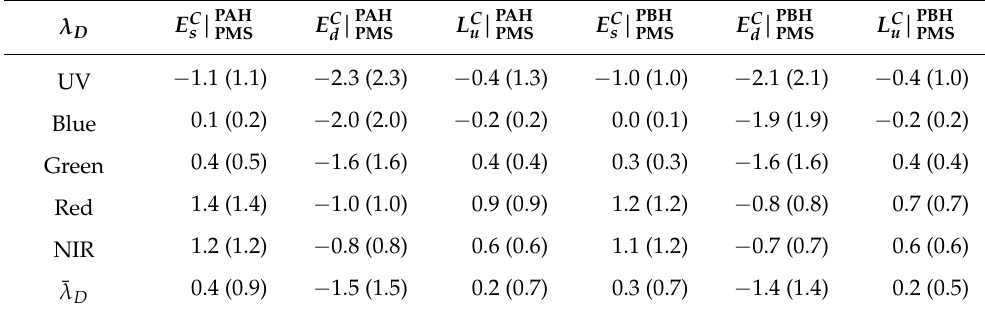
Table 1. The ψ and φ comparison statistics in percent, with the latter in parentheses, as a function of spectral domains (Section 2.6) for the two detector systems built into a C-PHIRE radiometer based on calibration data, wherein PAH band-averaged hyperspectral data (left three columns) versus PBH bandpass hyperspectral data (right three columns) are compared with PMS multispectral data. The last row provides statistical averages across five spectral domains, ¯ λ D